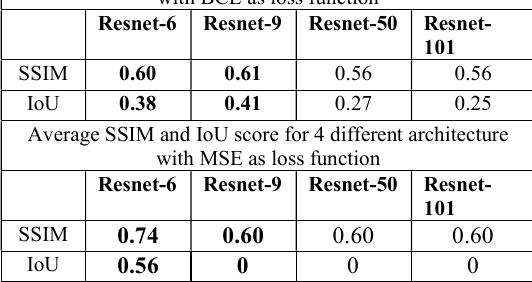
Table 1. The average SSIM and IoU score computed for the residual networks with two different loss functions